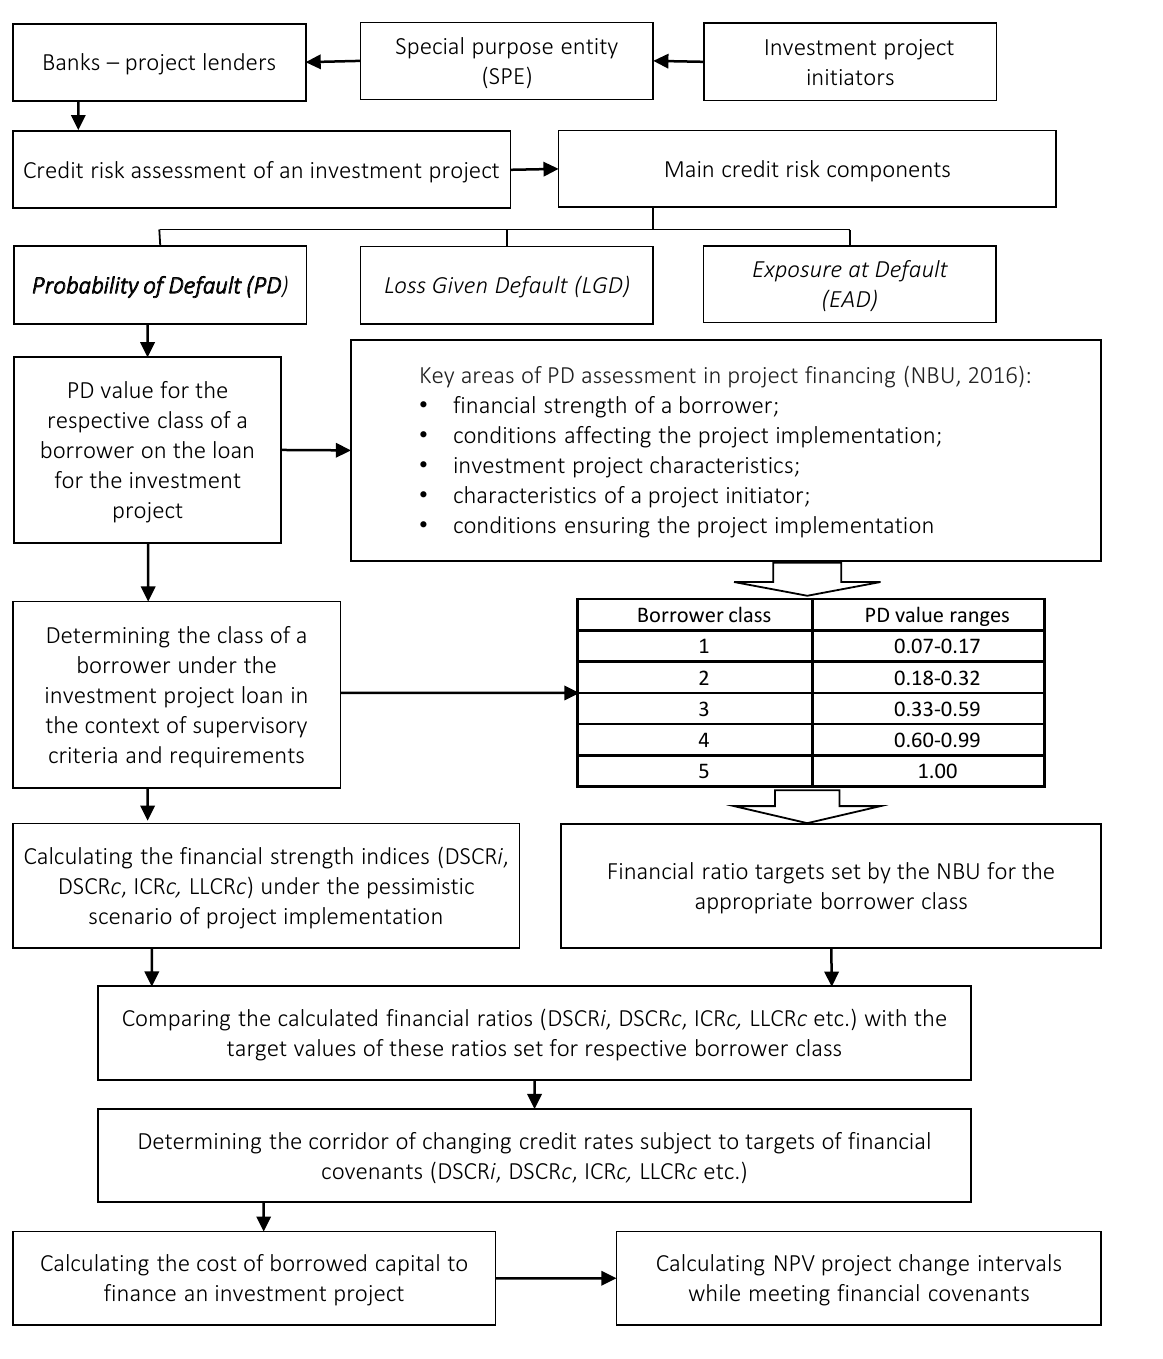
Figure 1. Main stages of determining the value of borrowed capital to finance an investment project by reference to financial